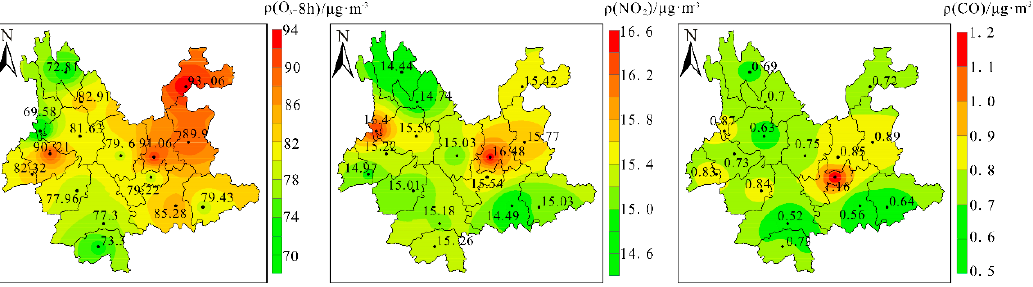
Figure 3. The average spatial distribution of O 3 -8h, NO 2 and CO in Yunnan Plateau from 2015 to 2020. to